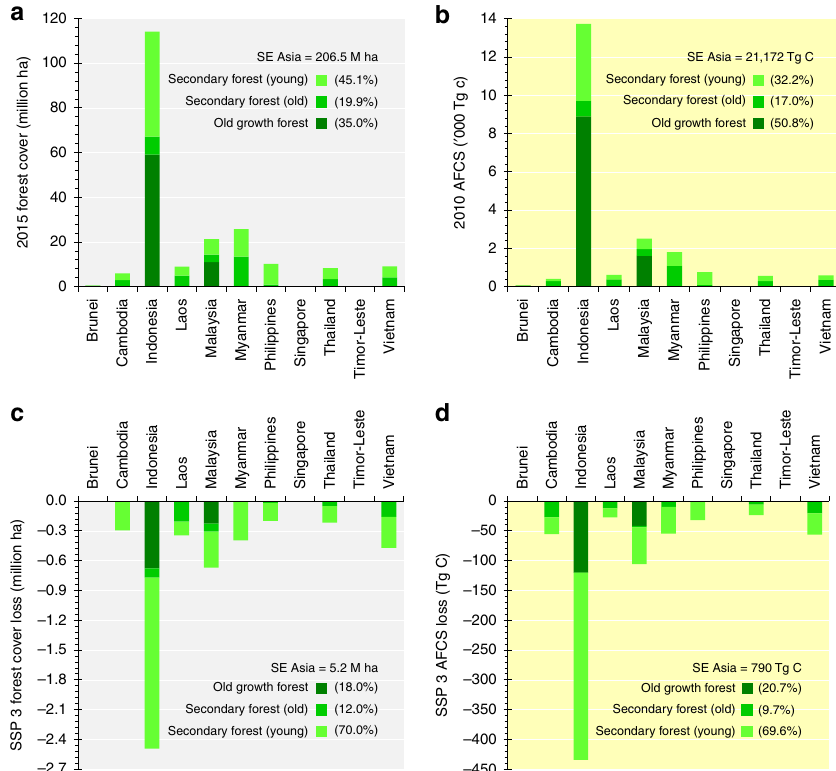
Fig. 4 Forest cover and aboveground forest carbon stock (AFCS) in Southeast Asia, and their respective losses by 2050 across forest classes under the worst-case scenario (SSP 3). Country-level distribution of the current forest cover and AFCS considering forest classes ( a , b ) and country-level distribution of projected forest cover and AFCS losses across forest classes ( c , d ). For ( b ), the extent of forest in 2015 was used. The graph for the other forest-losing scenario, SSP 5, is presented in Supplementary Figure